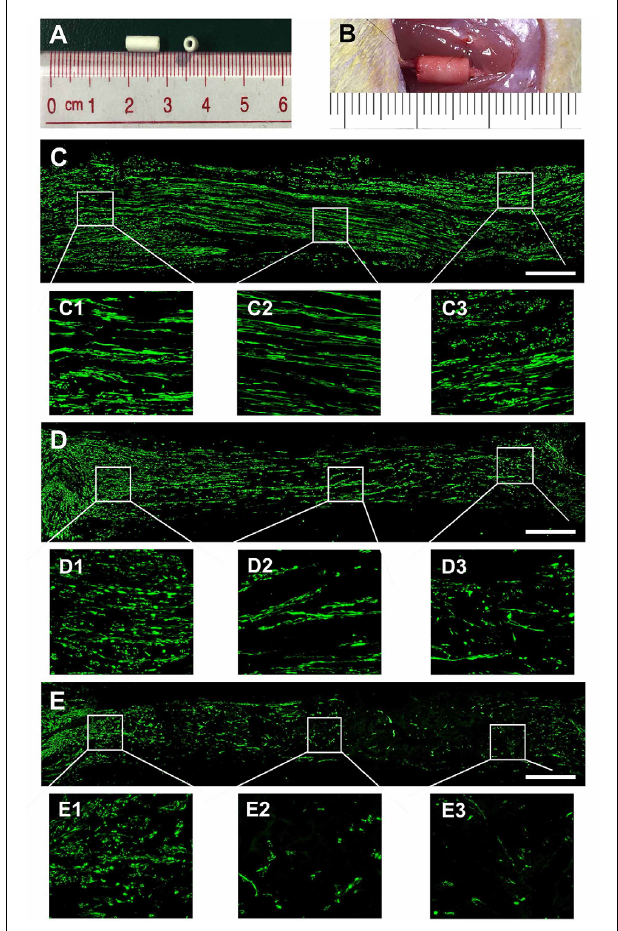
FIGURE 4 | Nerve regeneration in the grafts at 4 weeks. Notes: (A) gross appearance of the graft conduit. (B) Sciatic nerve graft conduit after implantation. Regenerated nerves were stained for NF160 in the autograft group (C) , EVs+conduit group (D) and PBS+conduit group (E) . The representative images of proximal, middle and distal section of the graft in the autograft (C1–C3) , EVs+conduit group (D1–D3) and PBS+conduit group (E1–E3) ; in the EVs+conduit group and PBS+conduit group, in addition to the same volume of EVs and PBS, the same volume of Matrigel (cid:114) was added to provide a supportive environment; n = 4 per group, scale bars: (C–E) 500 µ m. Abbreviations: EVs, extracellular